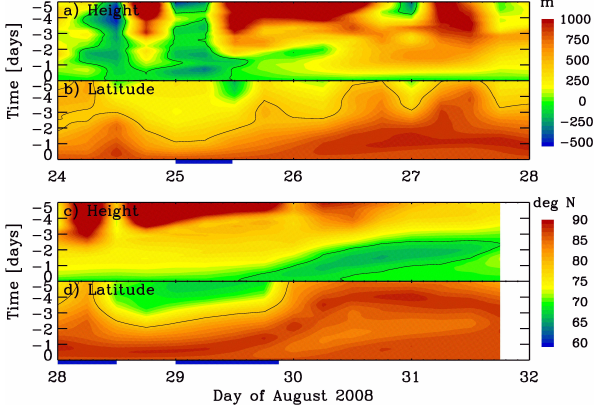
Fig. 2. Five-day back trajectories for an arrival height at Oden of 0.5km, including (a, c) the trajectory height relative to 0.5km, and (b, d) the trajectory latitude. Two different 4-day periods from the end of August are plotted. The black contour in (a) and (c) desig- nates a height of 0km (i.e., no height change), while the black con- tour in (b) and (d) designates a latitude of 80 ◦ N, which is the ap- proximate sea-ice edge at the time of study. Color scales for height and latitude are given to the right of the upper and lower panels, respectively. Case study periods are given as blue lines along the lower time axes.